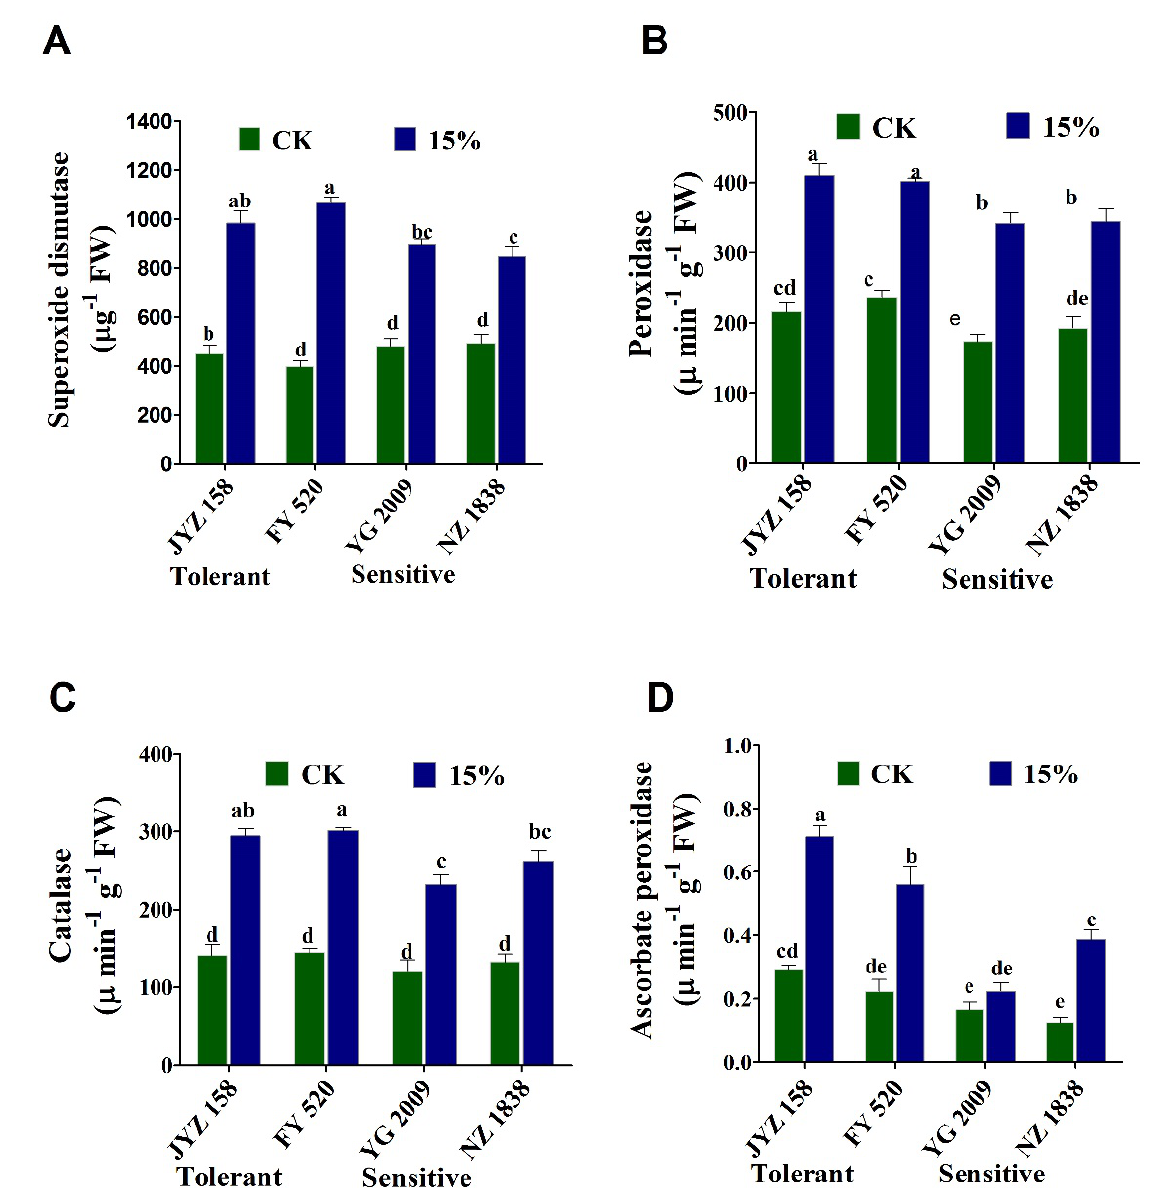
Figure 7. Effects of drought stress (PEG-6000 induced) on ( A ) superoxide dismutase (SOD), ( B ) peroxidase (POD), ( C ) catalase (CAT) and ( D ) ascorbate peroxidase (APX) in tolerant and sensitive rapeseed cultivars. Bars represent mean ± SE of three replicates. The different letters indicate significant differences at p < 0.05 using Duncan’s multiple range tests.